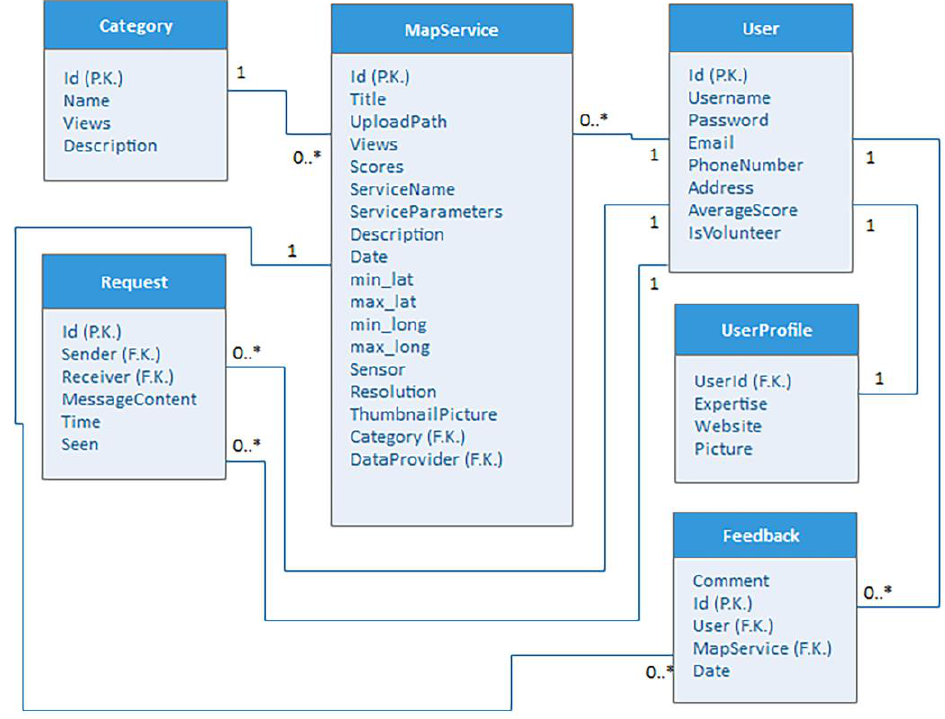
Figure 4. A data model for the implementation of OCCGEOP.